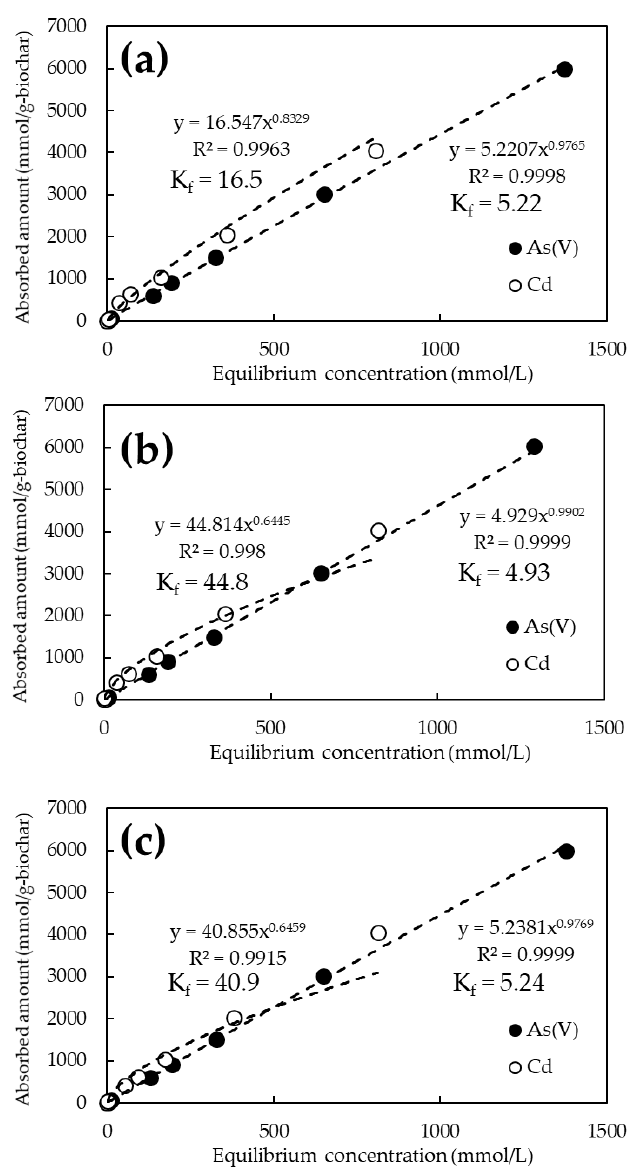
Figure 4. As(V) and Cd adsorption isotherms for biochars at various pyrolysis temperatures. ( a ) Pyrolysis temperature: 600 °C; ( b ) Pyrolysis temperature: 800 °C; ( c ) Pyrolysis temperature: 1200 °C.